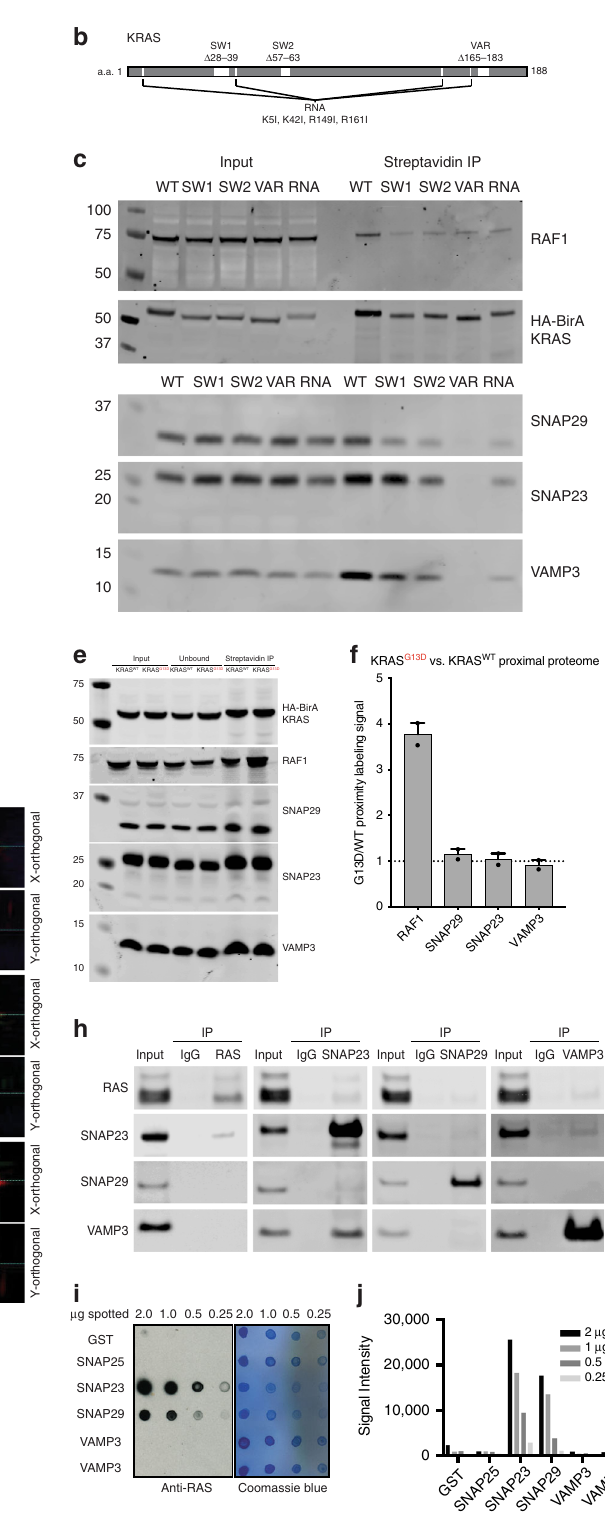
RNAs thus modulate KRAS proximity to speci fi c SNARE relevant tissues for each isoform. This revealed a KRAS- transport proteins. preferential proximity of SNAP23 (Supplementary Fig. 2G). The regions of the KRAS protein required for SNARE protein SNARE protein proximity to KRAS in cells was con fi rmed via adjacency were next examined. Proximity labeling was repeated proximity ligation assay (PLA) 31,32 . SNAP23, SNAP29, and VAMP3 all co-localize with KRAS at a basal level, even in with mutations or deletions in KRAS functional domains. SNORD50A/B wild-type cells, but this co-localization greatly Deletions of either of the KRAS switch I or switch II regions increases in the absence of these RNAs (Fig. 2a). SNORD50A/B involved in effector binding reduced KRAS association with Raf1 NATURE COMMUNICATIONS| (2019) 10:5118